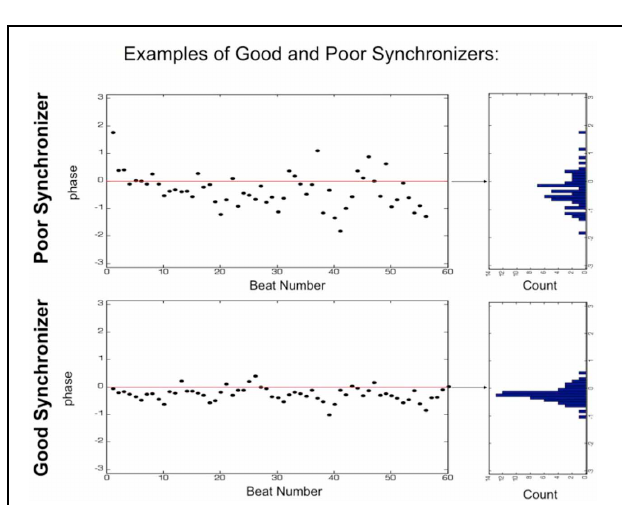
FIGURE 2 | The four sets of stimuli used in the Eriksen Flanker Task. Left to right: right incongruent, right congruent, left congruent, and left incongruent. The flanking arrows appear 50 milliseconds before the center one.